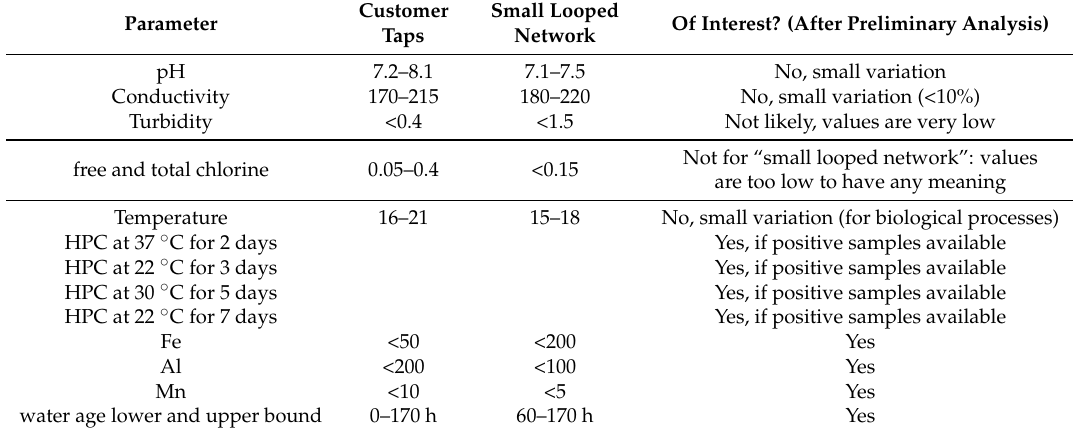
Table 4. Summary for the UK